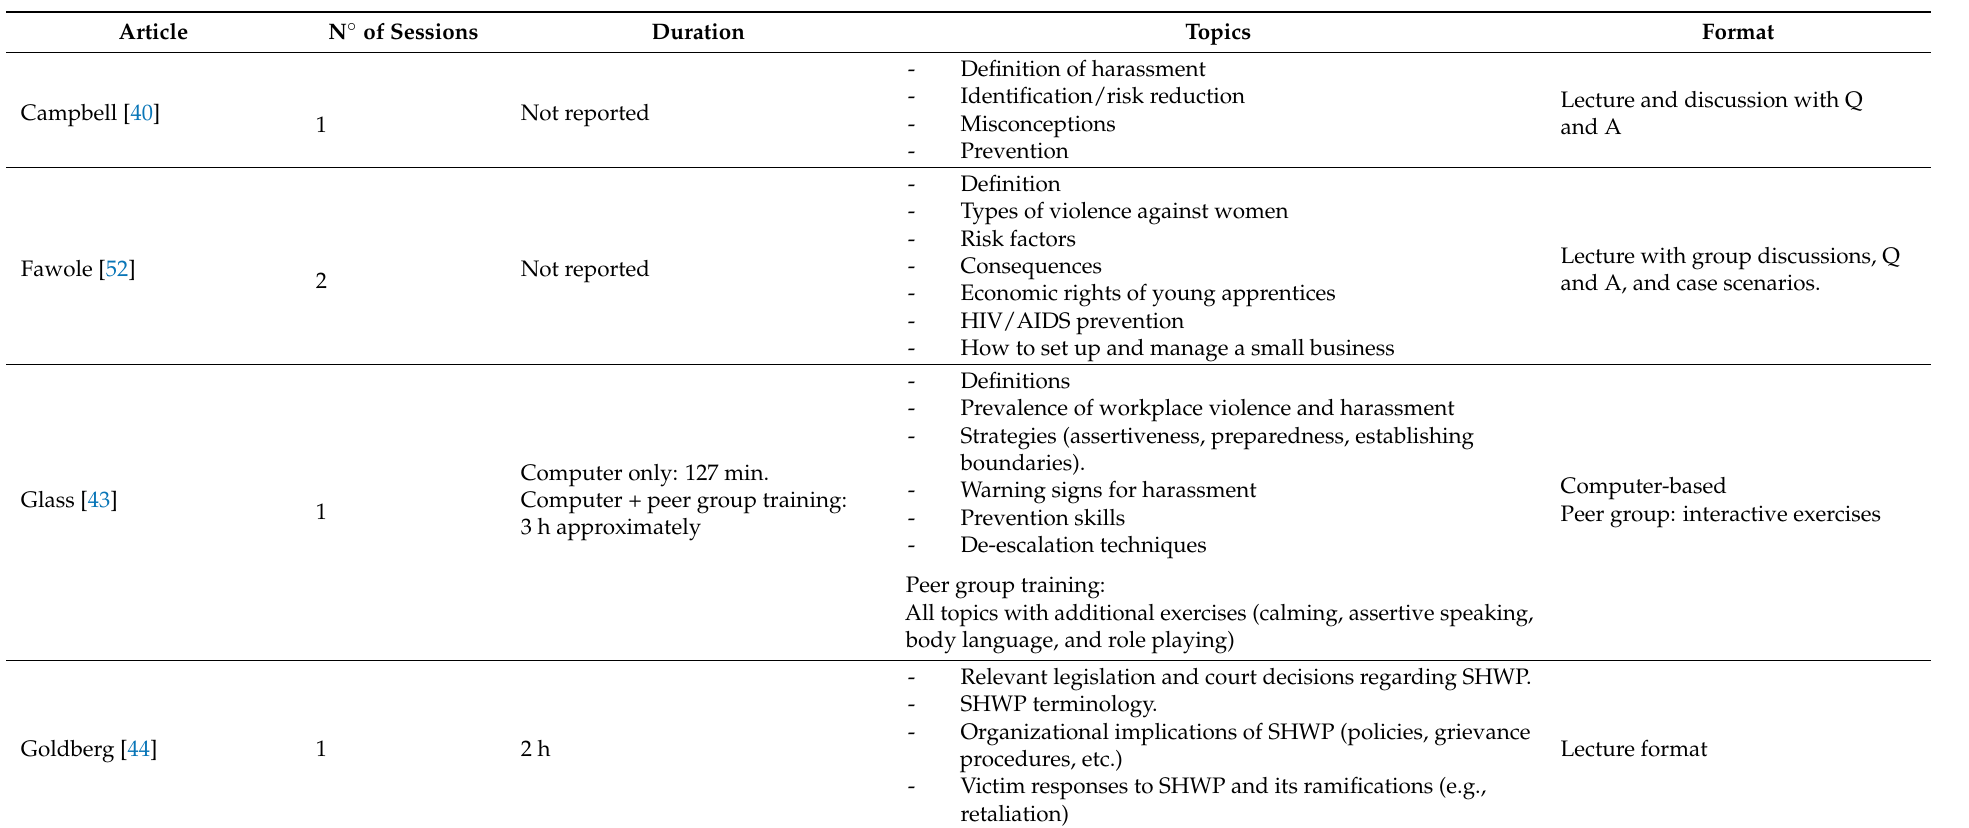
Table 3. Characteristics of SHWP prevention training (Only eight out of the eleven studies focused on training reported the number of sessions, duration and